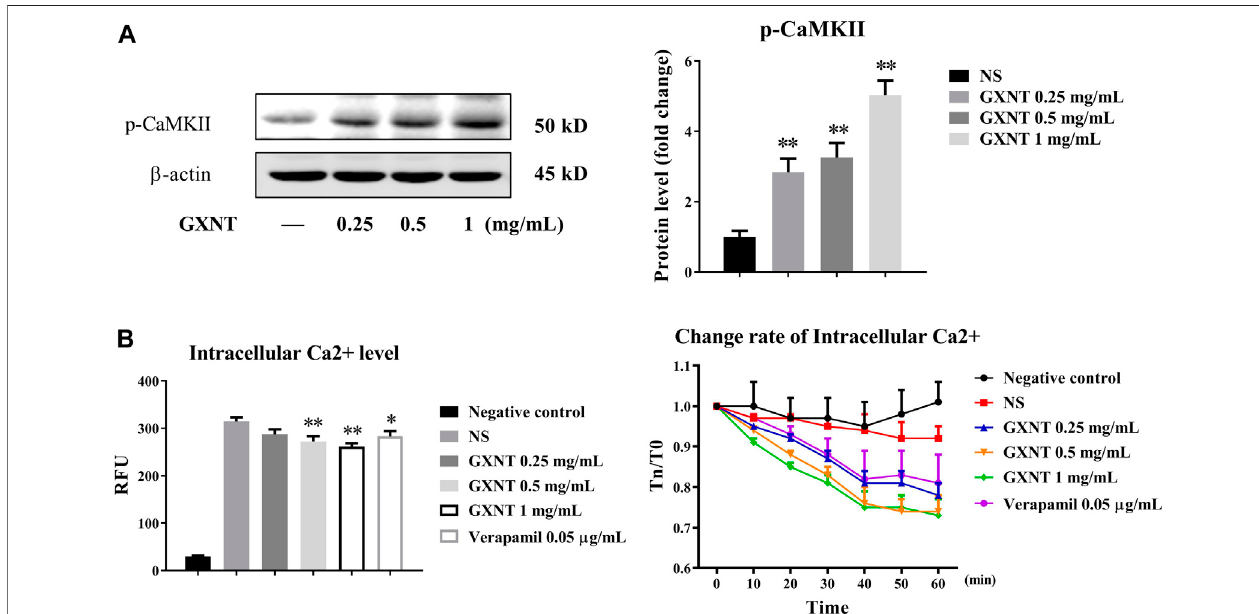
FIGURE5| Activationofcalmodulin-dependentproteinkinaseII(CaMKII)inendothelialcells(ECs)byGXNT. (A) Proteinexpressionofp-CAMKIIinHUVECstreated with GXNT. HUVECs were incubated with 0.25, 0.5, and 1 mg/ml GXNT for 24 h before protein levels were tested by Western blotting. Proteins were quanti fi ed accordingtothegrayvalueofthebands,andthefoldchangesrepresenttheratioofothergroupstothecontrolgroup. (B) TheeffectofGXNTonintracellularfreecalcium of ECs. HUVECs preloaded with a fl uorescent probe were treated with 0.25, 0.5, and 1 mg/ml of GXNT, and the change in Ca 2+ was detected immediately (left, 0 min), and continuous change rate (right, 0 – 60 min) was also observed every 10 min. The change rate was calculated as T N /T 0 × 100%, where T N represents the fl uorescence value at N min ( *p < 0.05, **p < 0.01 compared with the NS group). Results are presented as the mean ± SD of data obtained in three independent